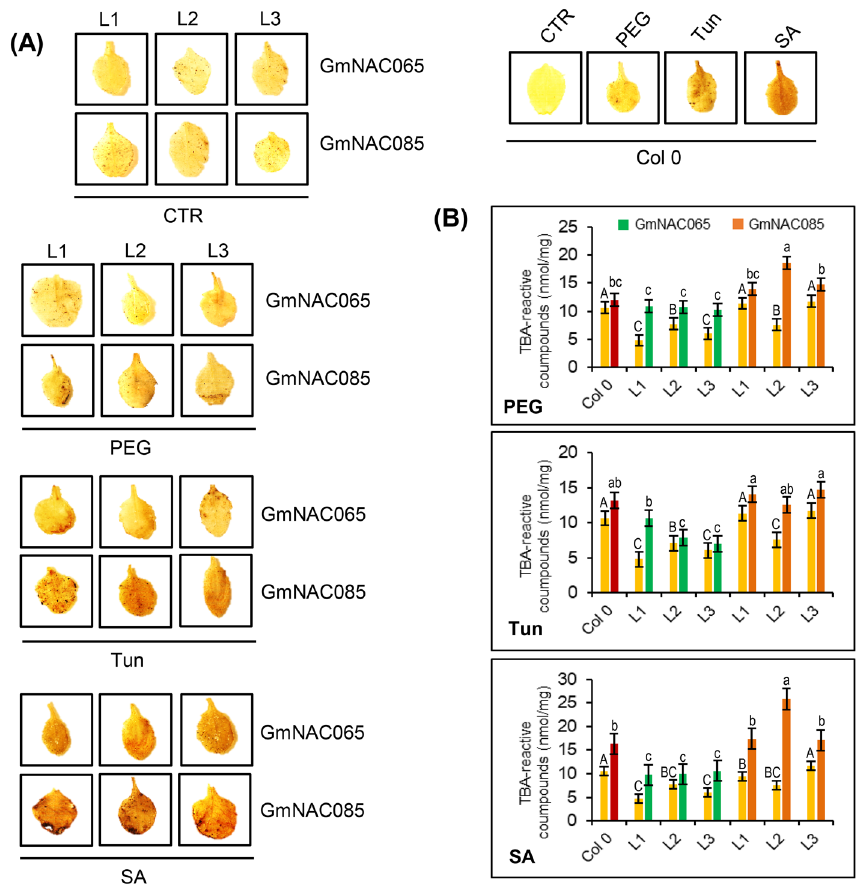
Figure 5. Expression of GmNAC065 and GmNAC085 leads to H 2 O 2 accumulation and lipid peroxidation. ( A ) DAB-leaf staining to detect H 2 O 2 accumulation in Arabidopsis leaves submitted to different stresses (PEG 8000—10% w/v; Tun—5 µg/mL; SA—75 µM) for 24 h. ( B ) TBA-reactive compounds quantification in GmNAC065-OX and GmNAC085-OX lines under different stresses. Solid bars show data from untreated plants. Upper bars indicate standard error (95% of confidence). Uppercase letters indicate significant differences among control samples and lowercase letters indicate significant differences among treated samples by the Tukey’s test (p < 0.05, n =